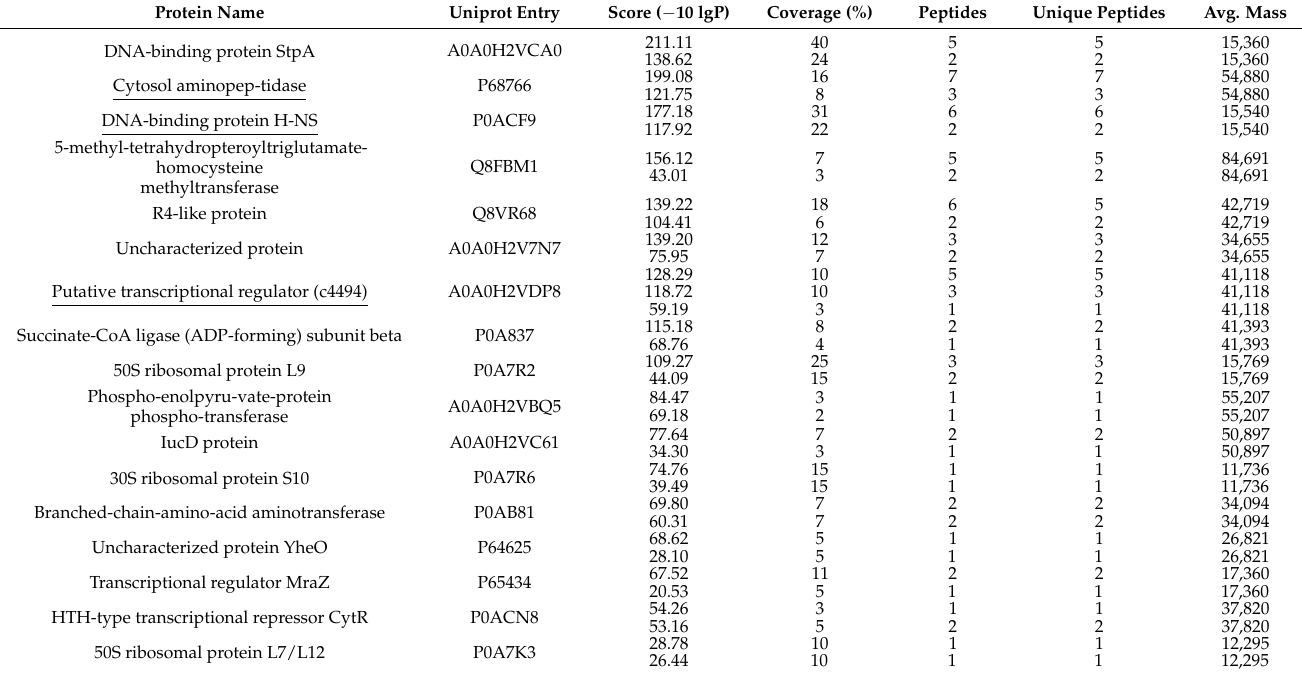
Table 1. Identification of proteins binding to the P2